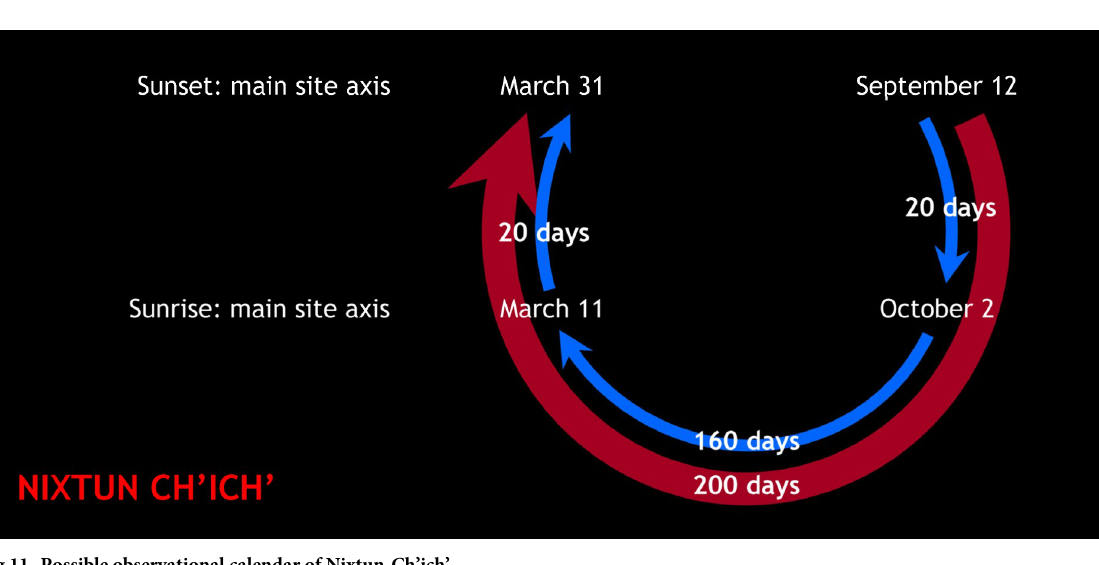
Fig 11. Possible observational calendar of